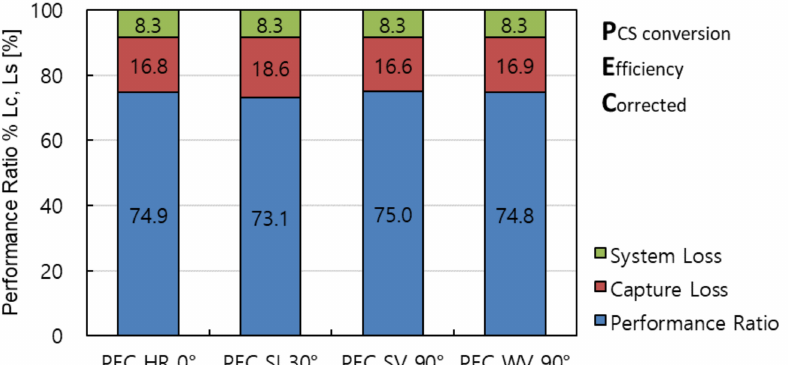
Figure 14. Power conditioning system (PCS) conversion efficiency-corrected performance ratio (PR) of each